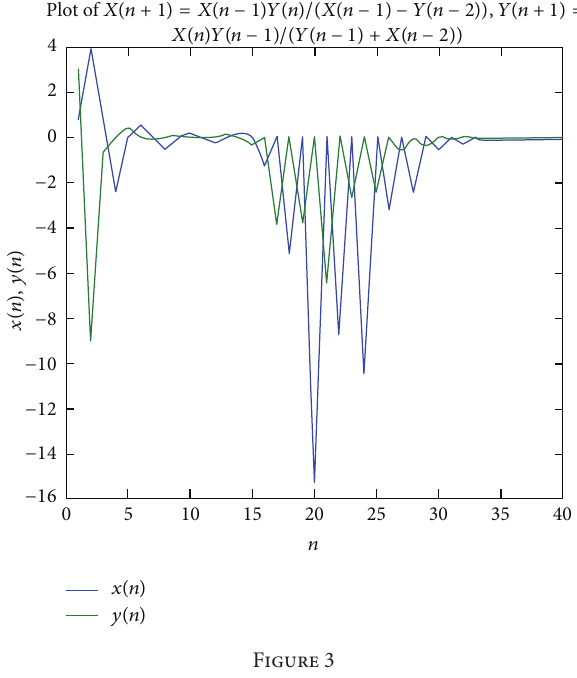
Example 18. Consider system (33) with the initial values = 0.8 , 𝑥 = 4 , 𝑥 = 0.15 , 𝑦 𝑥 −2 −1 0 = −0.6 . See Figure 𝑦 0